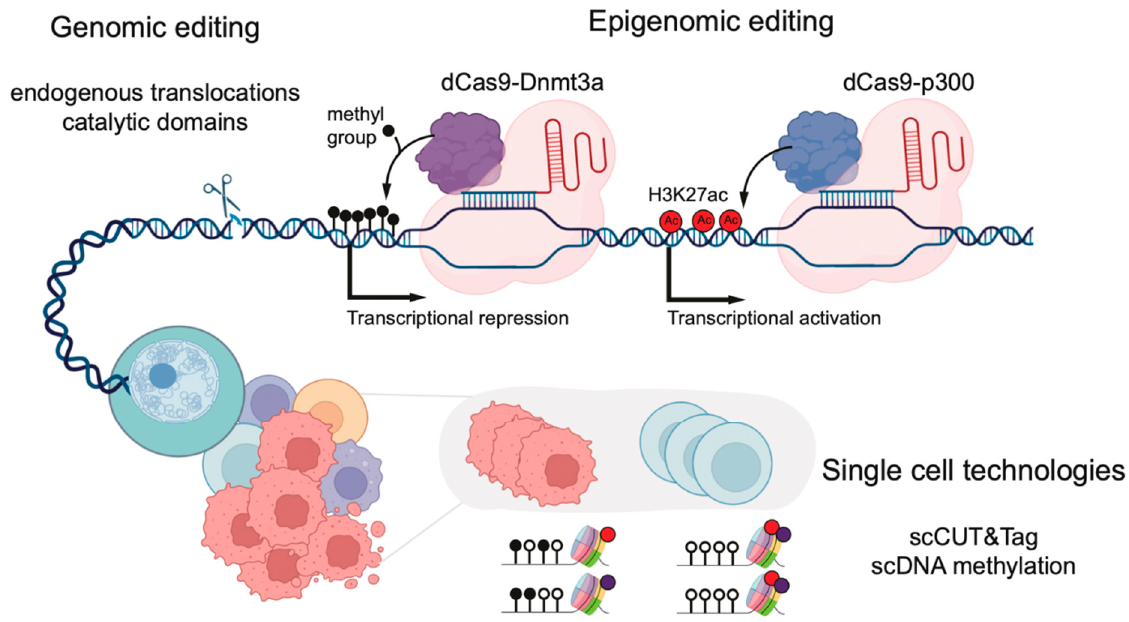
Figure 2. New technologies used to study epigenetic regulation in the hematopoietic system. dCas9 fused to proteins catalyzing DNA methylation (e.g., DNMT3A) or depositing histone modifications (p300; H3K27ac) can be used to modulate epigenetic marks in targeted genomic regions. Newly developed CRISPR-Cas9 systems can also be used to generate endogenous translocations between epigenetic regulators, and single-cell multi-omic technologies provide novel insights into the layers of epigenomic regulation in individual cells.